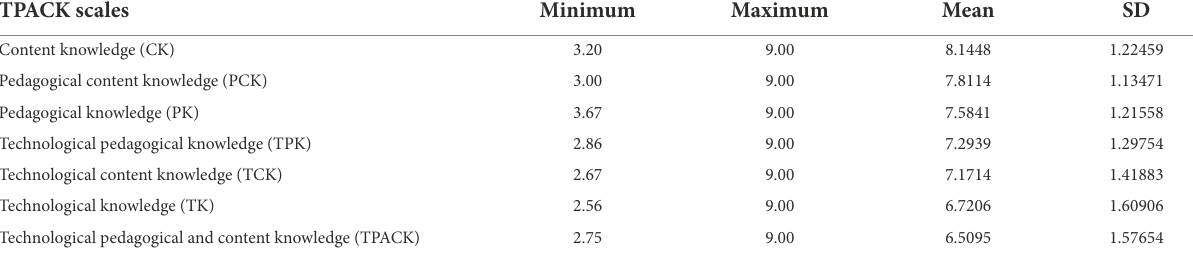
TABLE 1 Descriptive statistics for teachers’ overall beliefs towards